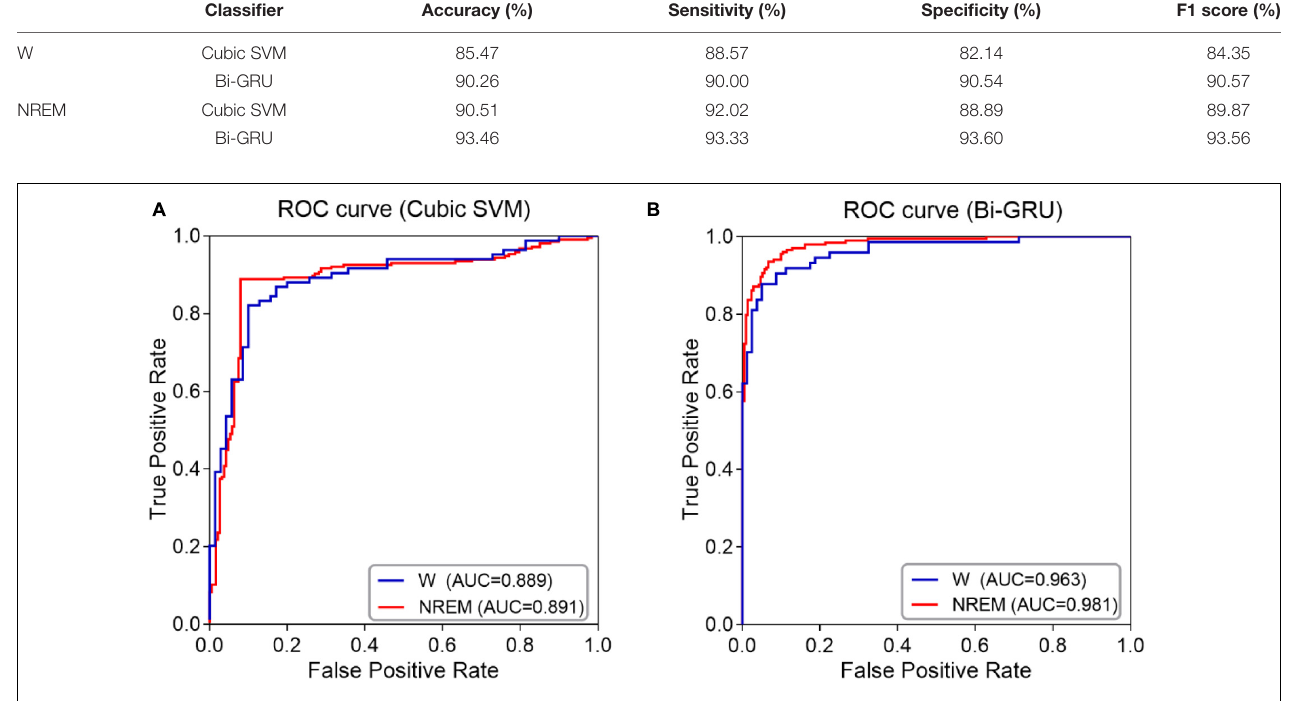
TABLE 3 | Classification performance comparison between EEG during NREM sleep and wakefulness for distinguishing MCI from HC.